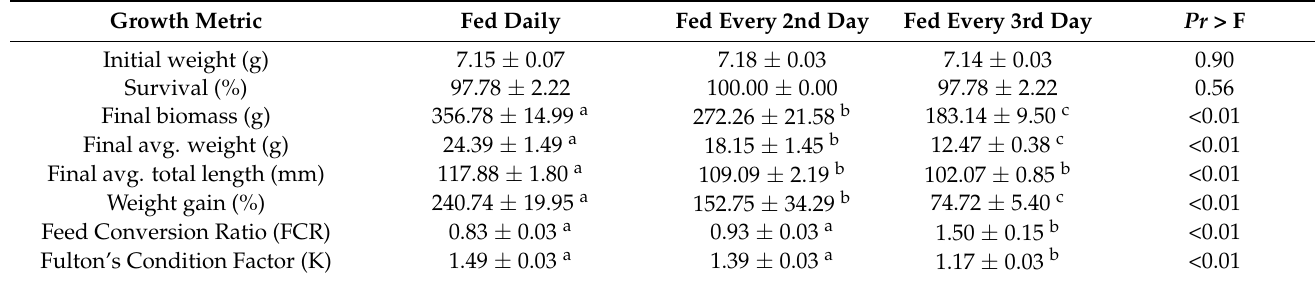
Table 5. Growth metrics of northern Largemouth bass fingerlings (Trial